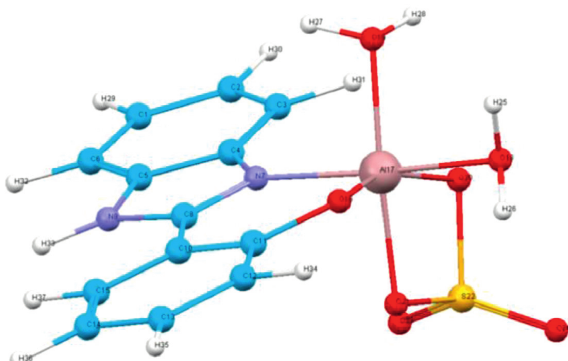
Figure 8: The fully optimized geometries of the synthesized Al + complex.